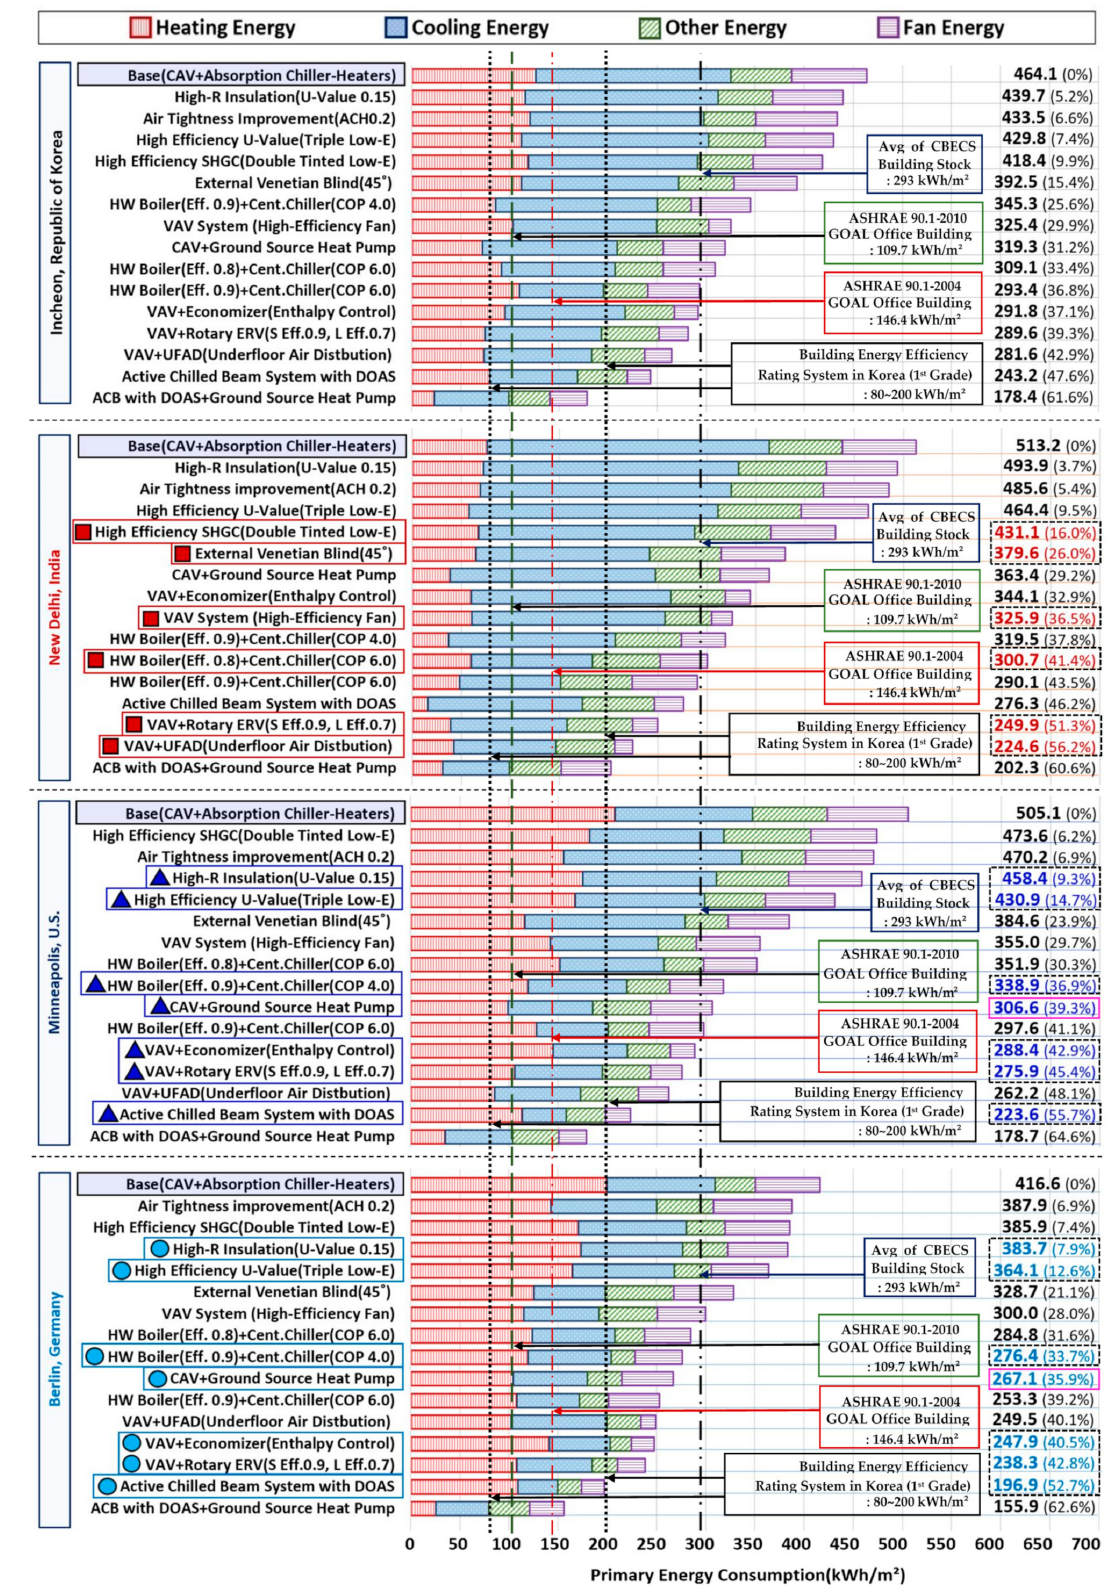
Figure 10. Primary energy consumption and energy saving potential (%) in each technology (four